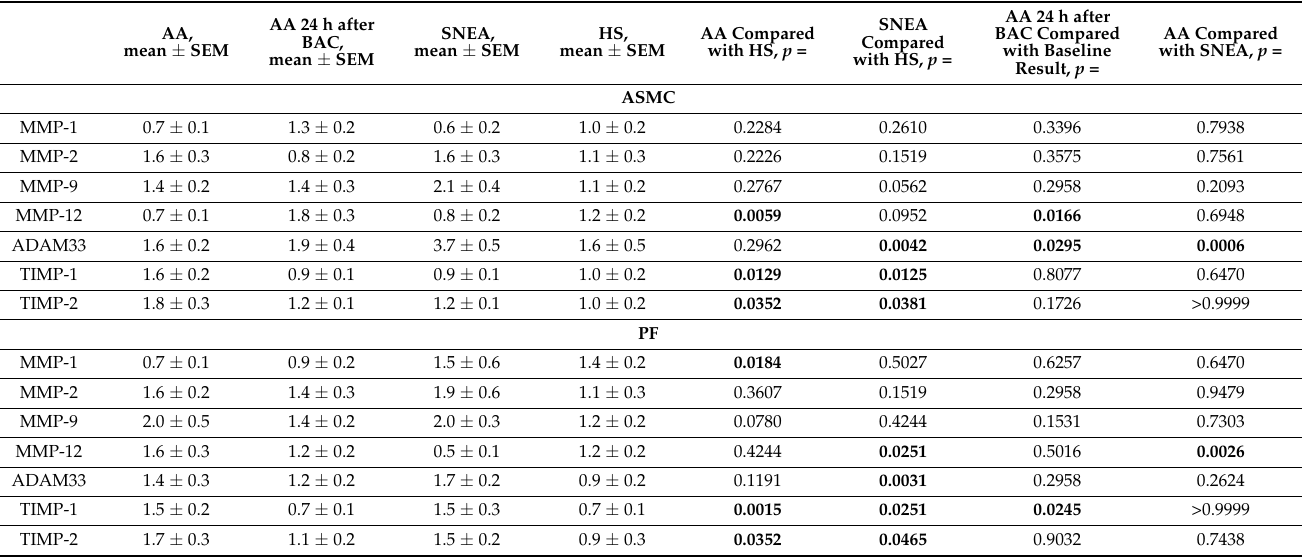
Table A4. The results of MMP and TIMP gene expression analysis and significant changes in gene expression levels.